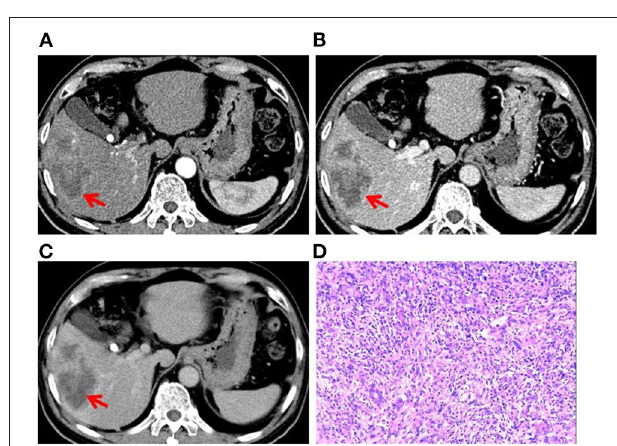
FIGURE 3 | Case 3: A 63-year-old man presented with pain in the right upper quadrant since 1 month. (A) A round mass in the S5 segment of the liver. CT scan in the arterial phase showed uneven, mild to moderate enhancement of the lesion. Tumor vessels were visible in the tumor. Irregular thick-walled sac-variable regions (red arrows) were seen in the lesion. (B) CT scan in the portal-vein phase showed gradual filling of the lesion from the edge to the center, with irregular thick-walled sac-variable regions (red arrow). (C) CT scan in the prolongation phase showed gradual filling of the lesion from the edge to the center, with irregular thick-walled sac-variable regions (red arrow). The tumor was surrounded by a pseudocapsule. (D) Histopathological examination of surgical specimen showing PLCS. Cancerous tissue (cholangiocarcinoma) was interspersed with sarcomatous tissue (malignant fibrous tissue).